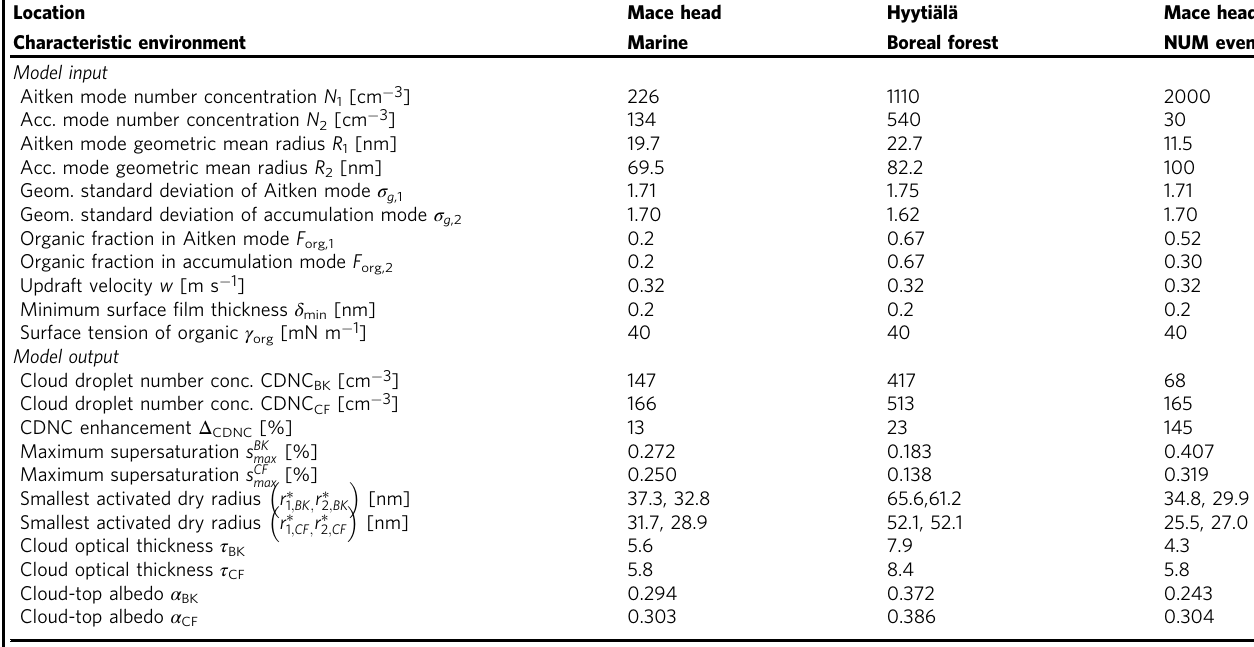
Optical properties are calculated assuming a cloud depth of 200m, CDNC values are reported at cloud top